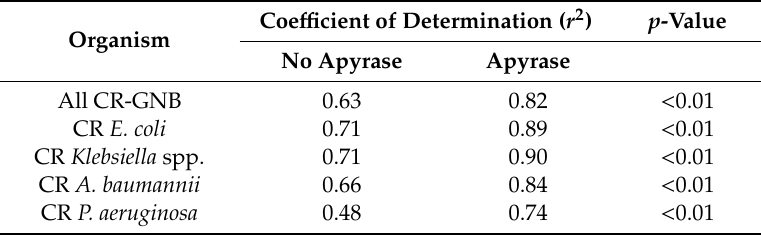
Table 2. Comparison of coe ffi cient of determination between viable counts (log 10 CFU / mL) and